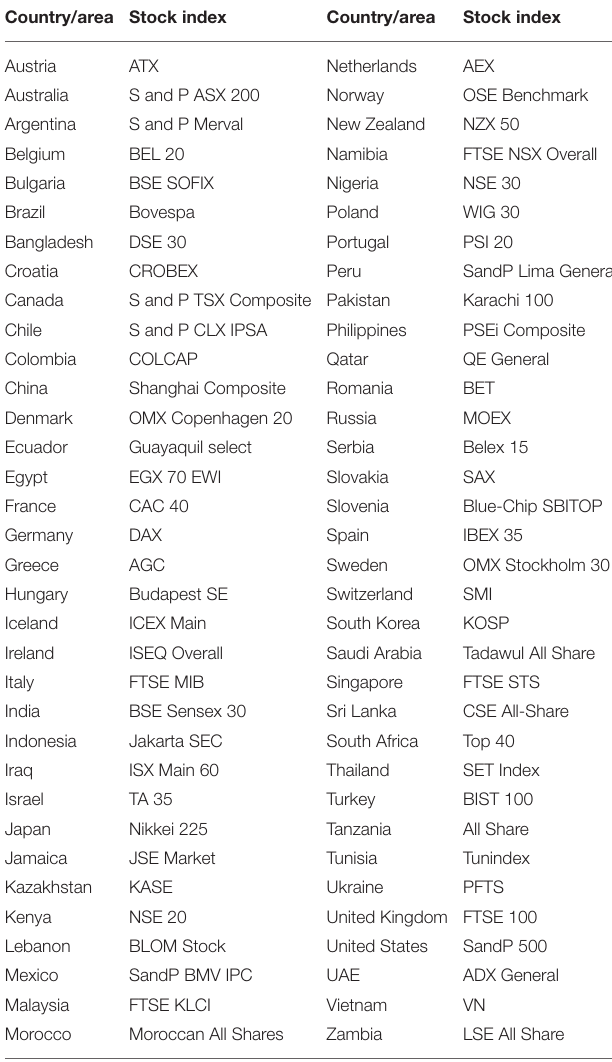
TABLE 1 | Major stock market